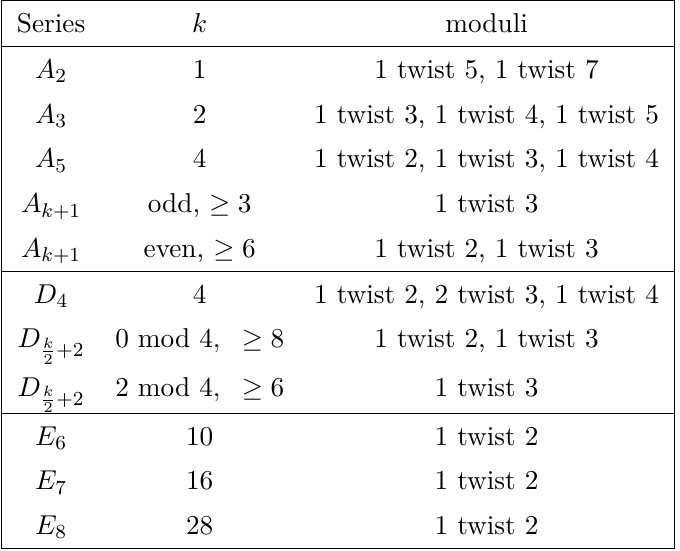
Table 2 . Number of twisted sector single-trace moduli for symmetric product orbifolds of the ADE minimal models. The central charge of the minimal models is related to the parameter k by c = 3 k and moreover k is even and k ≥ 4 . Although the primary ϕ R is not the same as the one used on the base, we emphasize that there is no tension: the allowed values of k perfectly agree with table 2, and when the state (4.24) is mapped